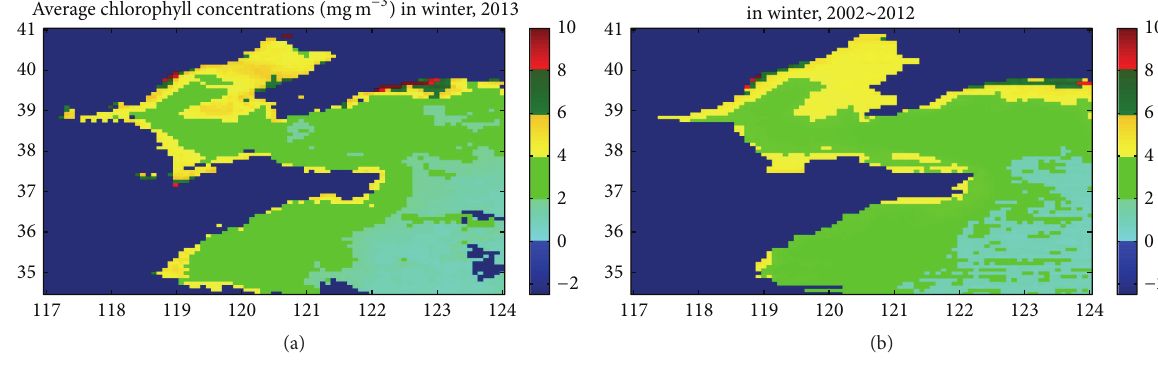
Figure 4: Average CHL distribution in winter 2013 (a) and 2002–2012 (b).